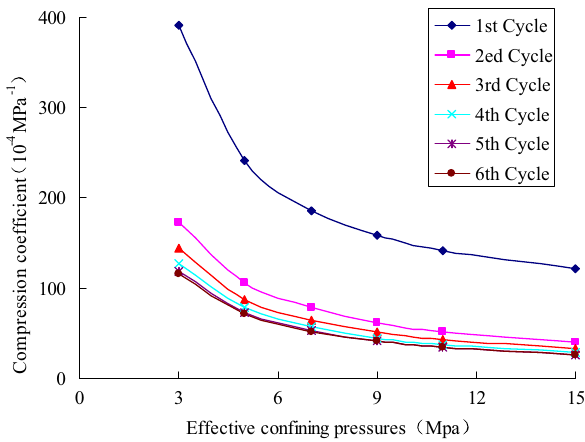
Fig. 4 Change laws of the compression coefficient with cycles and effective confining pressure (effective confining pressure is the difference between the confining pressure and pore pressure; the temperature is 280 (cid:3) C)